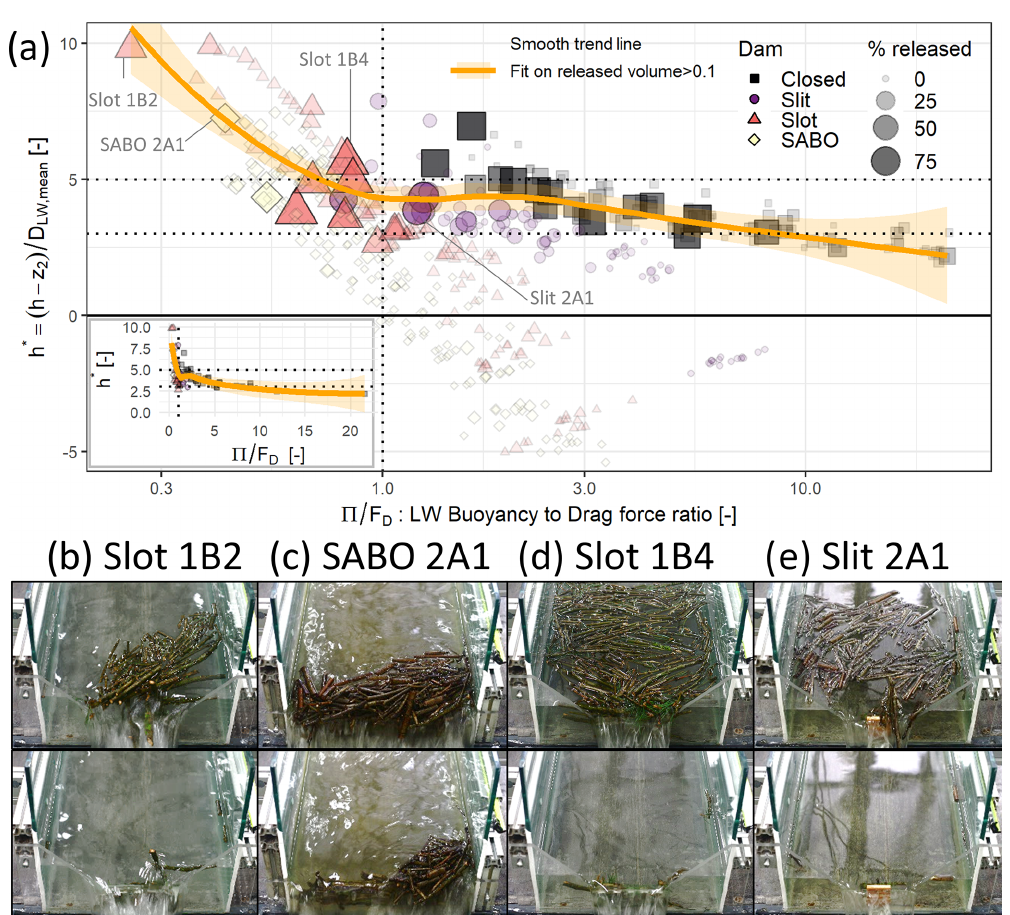
Figure 11. Characterizing release conditions: (a) dimensionless overtopping depth h ∗ vs. buoyancy-to-drag-force ratio (cid:53)/F D with dot size and opacity proportional to the amount of LW released. Inset: same figure with non-logarithmic x axis highlighting the sharp increase in h ∗ for significant releases; and (b–e) pictures of selected releases before (top picture) and after (bottom picture) releases. Releases occur for lower h ∗ values in the (cid:53)/F D (cid:29) 1 domain, i.e. if buoyancy prevails and floating carpets form with loosely packed logs (see d and e ), while releases occur for higher h ∗ values if dense jams form under high drag forces in the (cid:53)/F D (cid:28) 1 domain where densely packed jams forms (b, c) , eventually stabilized by protruding logs (see b , bottom